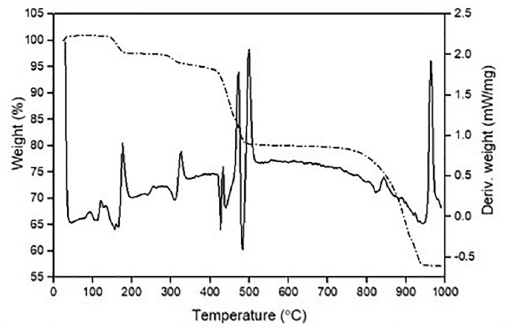
Figure 1. TG-DSC curves of the precursor (1000 W microwave irradiation power) from room temperature to 1000 °C. Gd O SO under the flow of hydrogen to form the Gd 2 2 4 nanophosphors as in Eq.1 23